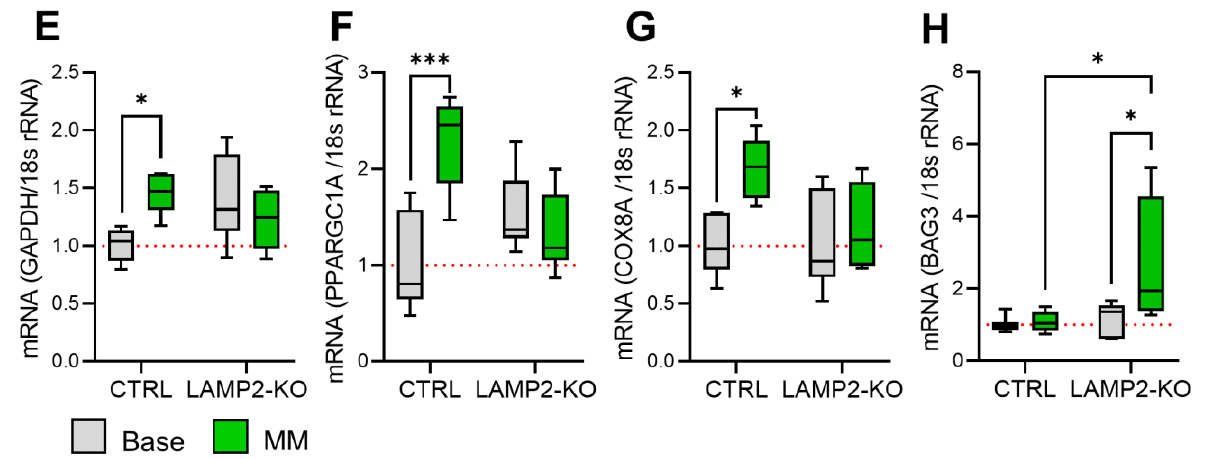
Figure 5. Real-time PCR quantification of mRNA expression of key cardiac genes in Ctrl and LAMP2 KO iPSC-CMs. ( A,B ) Increased expression of sarcomere and cytoskeletal genes ACTC1 ( A ) and MYBPC3 ( B ) genes in the Ctrl but not LAMP2 KO iCMs after MM treatment; ( C ) Decreased expression of adult troponin I subtype, TNNI3, in MM-treated LAMP2 KO cells; ( D ) Increased expression of CASQ2, which encodes Ca 2+ buffering protein calsequestrin-2 in the Ctrl but not LAMP2 KO iCMs after MM treatment; ( E – G ) Increased mitochondrial gene expression, such as GAPDH ( E ), PPARGC1A ( F ), and COX8A1 ( G ) in Ctrl but not LAMP2 KO cells after MM treatment; ( H ) Increased expression of BAG3, a cochaperone protein of HSP70, in LAMP2 KO but not Ctrl iCMs after MM treatment. Results from at least 3 independent experiments. Red dashed line indicates the relative mRNA expression in Ctrl group at base level were normalized to 1. * p < 0.05, ** p < 0.01, *** p < 0.001, and **** p < 0.0001 by two-way ANOVA test followed by Holm–Sidak method.